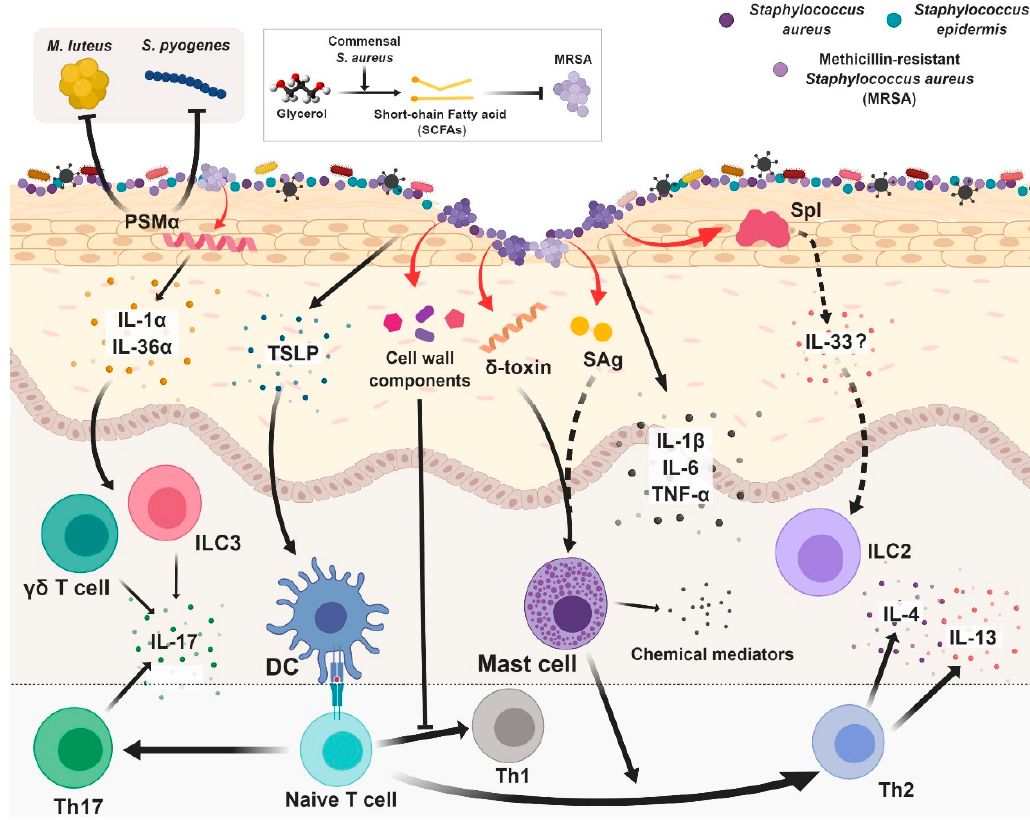
Figure 1. Interaction between Staphylococcus aureus and skin immune system. The skin immune system comprises a complex network of cells. Because keratinocytes serve as sensors, phenol-soluble modulin α (PSM α ) are capable of inducing epidermal keratinocytes to produce IL-1 and IL-36, even without epidermal disruption. T cells and innate lymphoid cells (ILC3) containing the IL-36 receptor recognize IL-13 and secrete IL-17, leading to inflammation. Another peptide belonging to the PSM family, δ -toxin, promotes Th2 responses by activating mast cells. It is likely that staphylococcal superantigens (SAgs) are also capable of mast cell activation. Thymic stromal lymphopoietin (TSLP) can drive Th2 skewing via dendritic cells (DCs). Cell wall components from S. aureus inhibit Th1 responses. S. aureus also possesses probiotic properties. S. aureus shows antimicrobial activity against other bacteria, such as M. luteus and S. pyogenes . Commensal S. aureus inhibits methicillin-resistant S. aureus (MRSA) using short-chain fatty acids (SCFAs) fermented from glycerol. Red arrows indicate bacteria-originated materials. T-bar indicates inhibitory